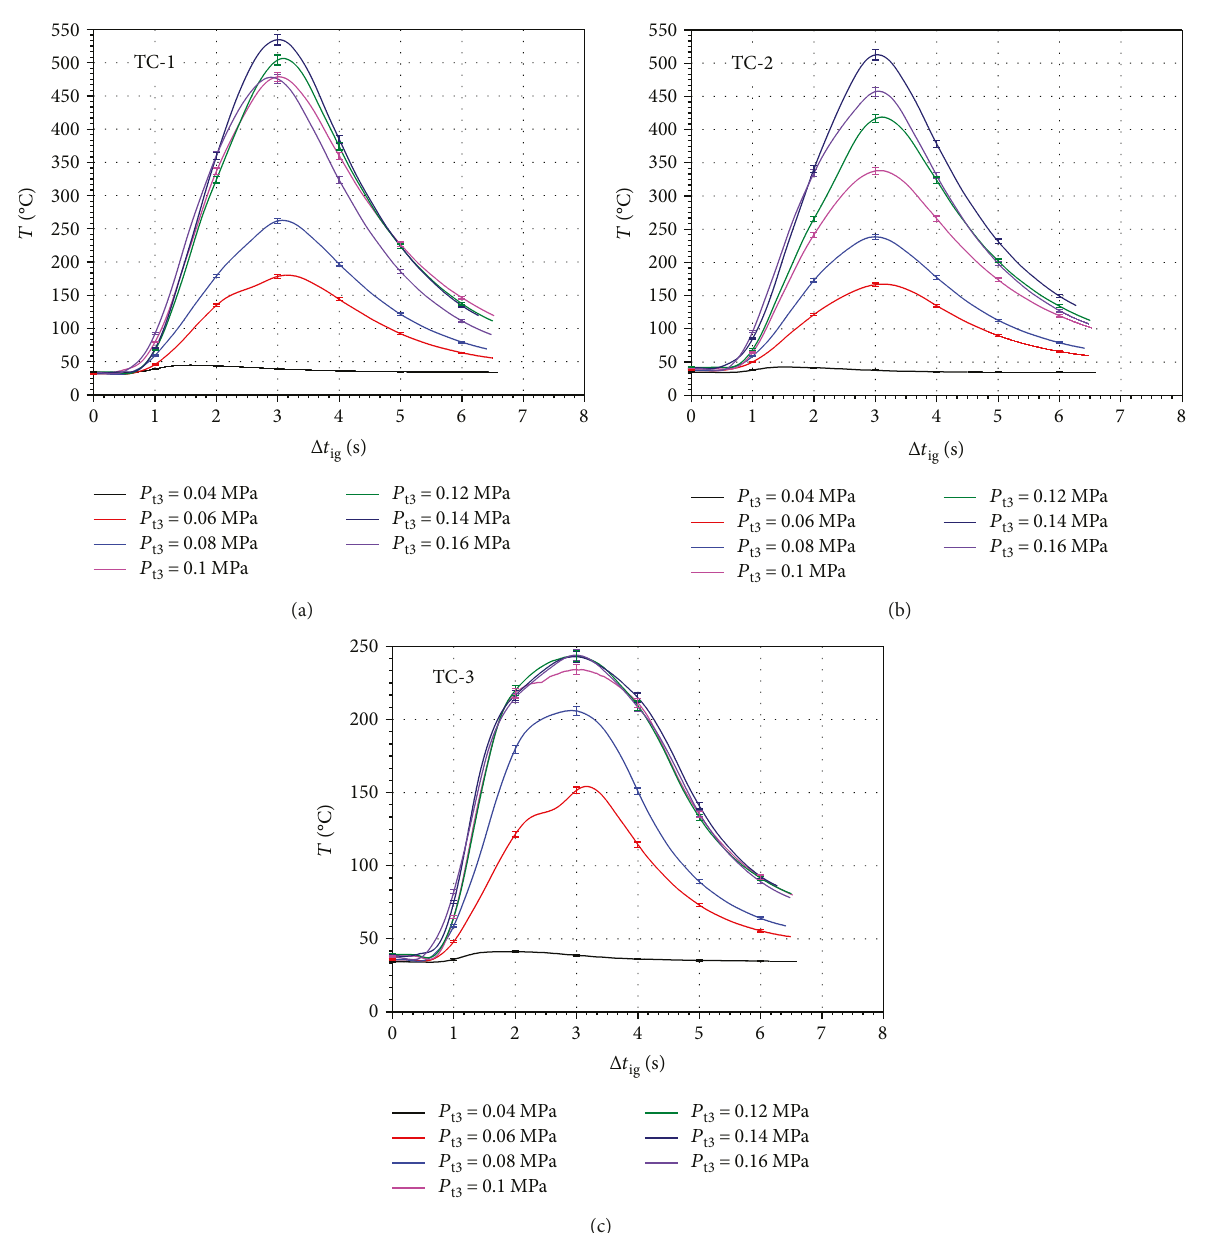
Figure 6: Temperature pro fi les at the combustion chamber exit. (a) TC-1 thermocouple, (b) TC-2 thermocouple, and (c) TC-3